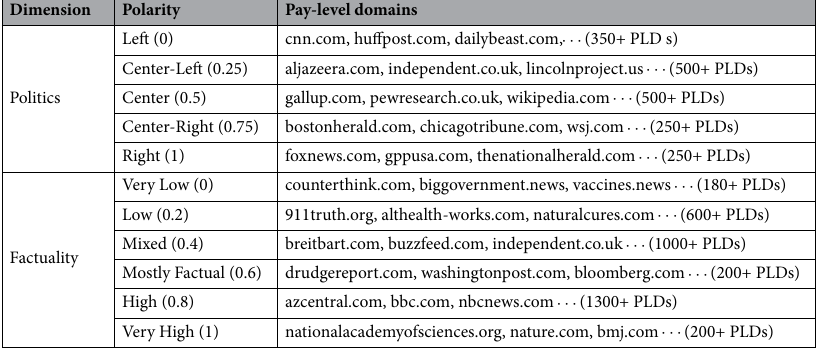
Table 2. Curated pay-level domains and their polarity scores along political and factual dimensions. For the political dimension, { 0, 0.25, 0.5, 0.75, 1 } represents Left , Center Left , Center/Unbiased , Center Right and Right sources respectively. Along the factuality or misinformation dimension, Very Low , Low , Mixed , Mostly Factual , High and Very High are quantified as { 0, 0.2, 0.4, 0.6, 0.8, 1 } in the same order.